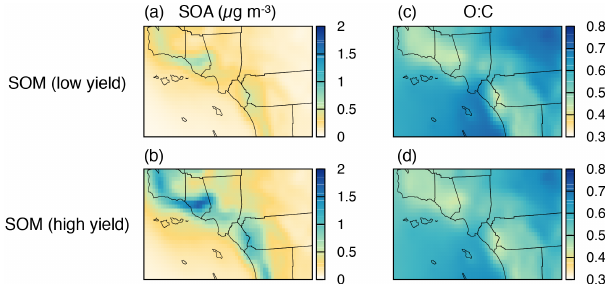
Figure 2. (a, b) 2-week averaged concentrations of SOA (in µgm − 3 ) and (c, d) 2-week averaged ratio of O : C for southern Cal- ifornia. (a, c) are predictions from the SOM (low yield) simulations and (b, d) are predictions from the SOM (high yield) simulations.